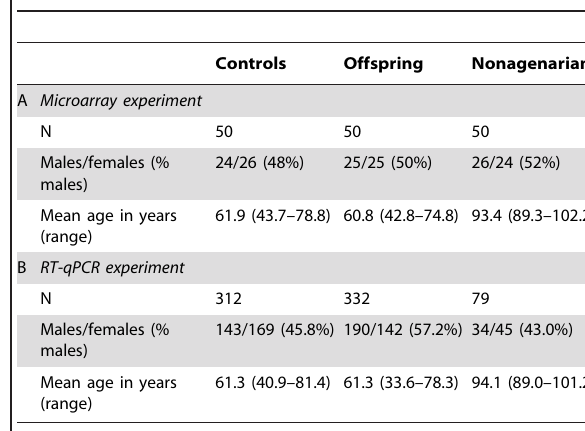
Table 1. Description of the participants of the LLS in the microarray and validation